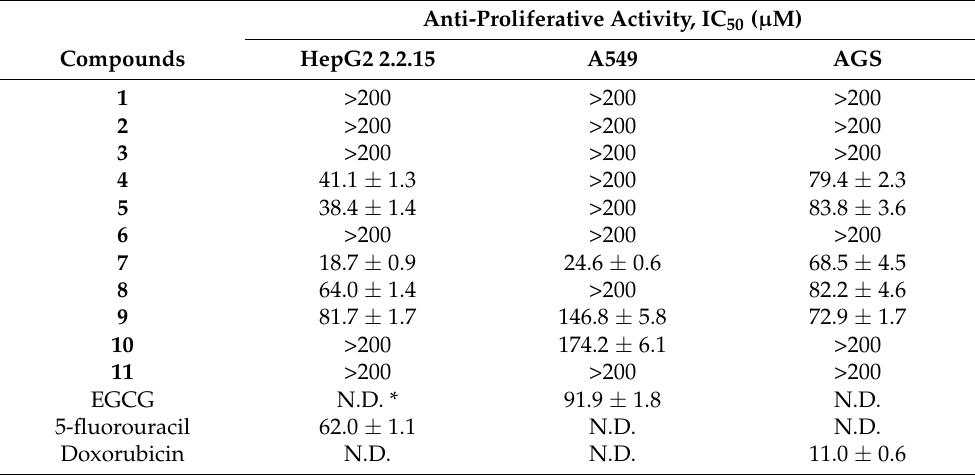
Table 3. Anti-proliferative activities of isolated compounds on tumor cell lines.